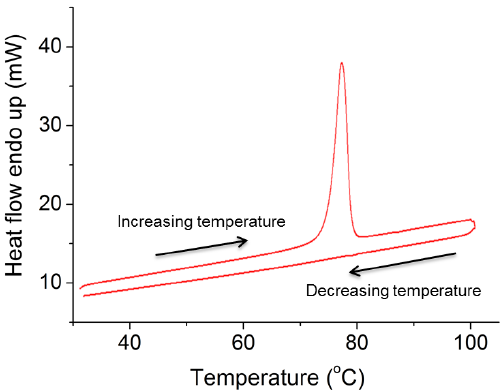
Figure 14. DSC thermograph scanning of recrystallized Ibp. The scanning rate was 10 °C/min, and the temperature range was from 30 to 100 °C.